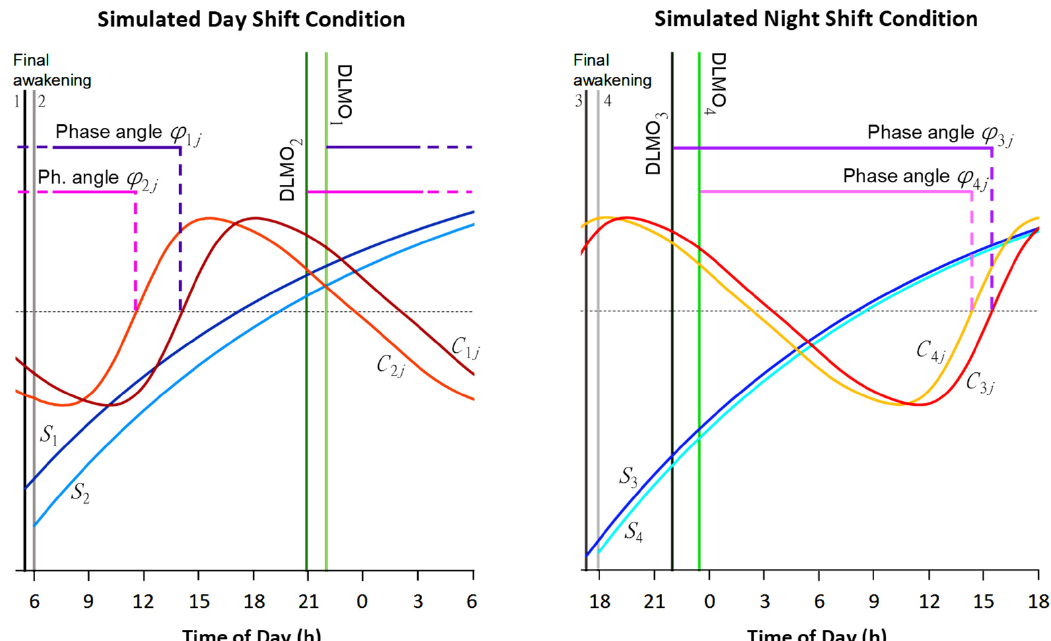
Figure 2. Schematic of the statistical approach. We modeled the effects of the circadian process C (orange-red curves) and the homeostatic process S (blue curves) on neurobehavioral functioning, illustrated here with four example (hypothetical) individuals (arbitrarily numbered 1–4) for a given neurobehavioral task j , plotted against clock time over the 24 h period of wakefulness of the CR protocol that followed the simulated day shift condition ( left panel ) and the simulated night shift condition ( right panel ). The statistical model included task-specific scaling factors for processes C and S and a task-specific intercept (not shown). We accounted for individual differences by expressing C in subject-specific circadian time, relative to individual DLMO (green vertical lines), and S in subject-specific time awake, relative to individual time of final awakening (gray-black vertical lines), and by estimating individualized initial state for process S at final awakening. Importantly, we also estimated individualized phase angles φ ij (purple-pink horizontal lines), denoting subject-specific circadian timing of the upward zero crossing (intersection with dotted horizontal line) of the effect of process C on performance for neurobehavioral task j . We compared the means of these phase angles over all subjects between our three distinct neurobehavioral tasks to address the question whether the endogenous circadian timing for optimal functioning was inherently task-dependent.